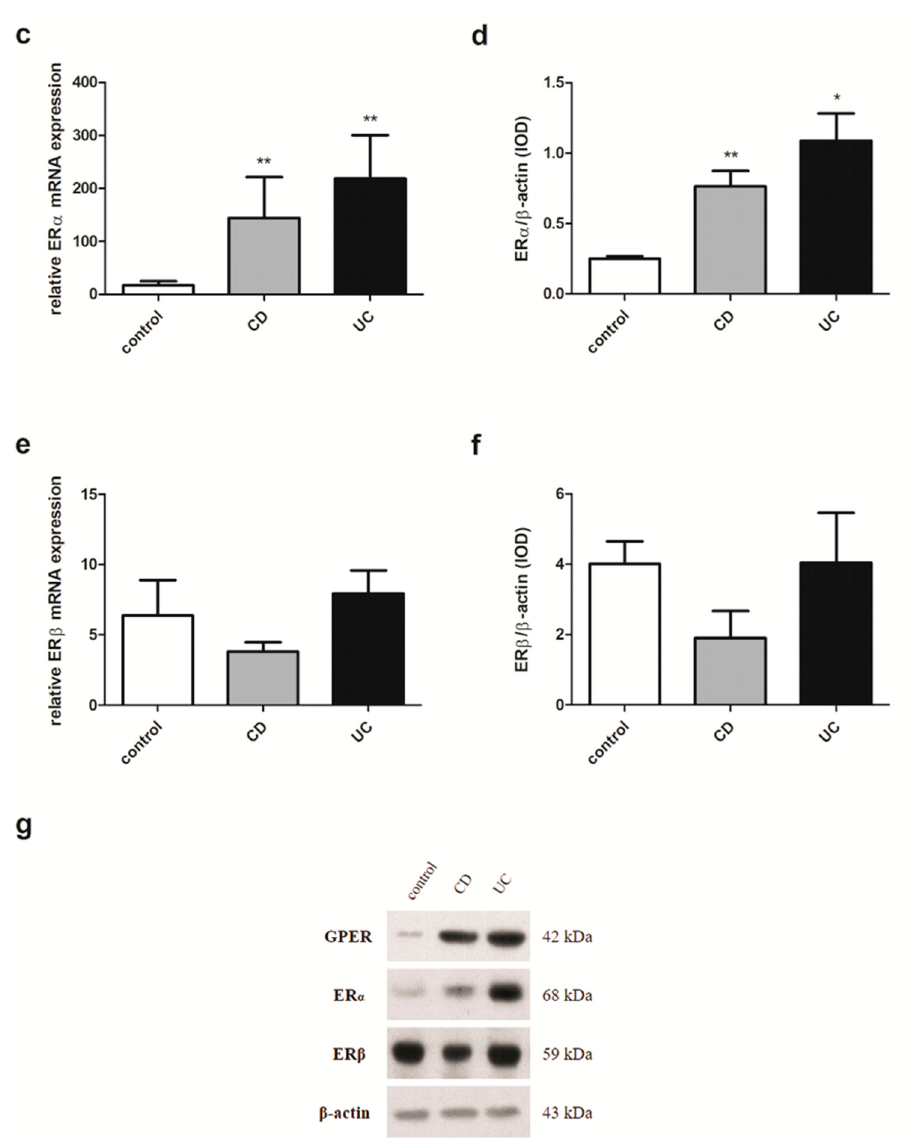
Figure 4. Expression of GPER ( a , b ), ER α ( c , d ) and ER β ( e , f ) at the mRNA ( a , c , e ) and protein level ( b , d , f ) in males with CD and UC and related controls (control, n = 12; CD, n = 19; UC, n = 24). Representative immunoblots of GPER, ER α and ER β ( g ). Values are means ± SEM; * P < 0.05, ** P < 0.01 vs. control.